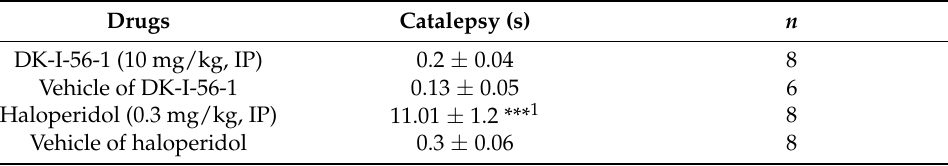
Table 1. Effects of DK-I-56-1, haloperidol on catalepsy in the bar test. *** p < 0.001 in comparison with DK-I-56-1.